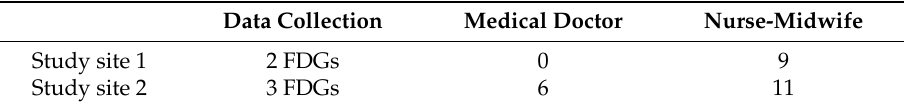
Table 1. Data collection per study